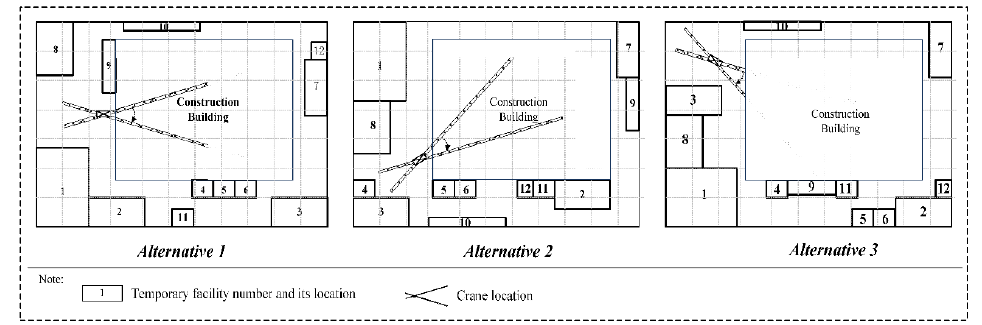
Figure 3. Temporary facility layout planning alternatives illustration.